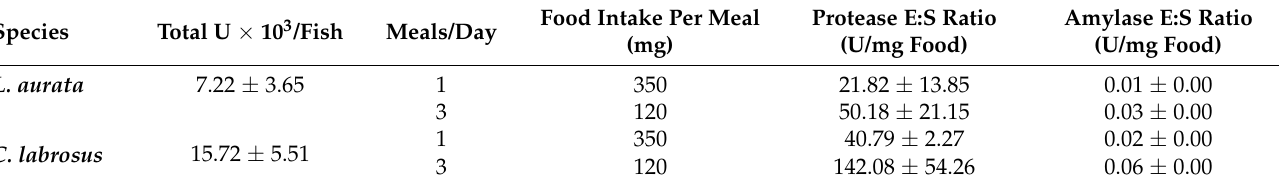
Table 2. Enzyme: substrate ratios used in the in vitro assays.